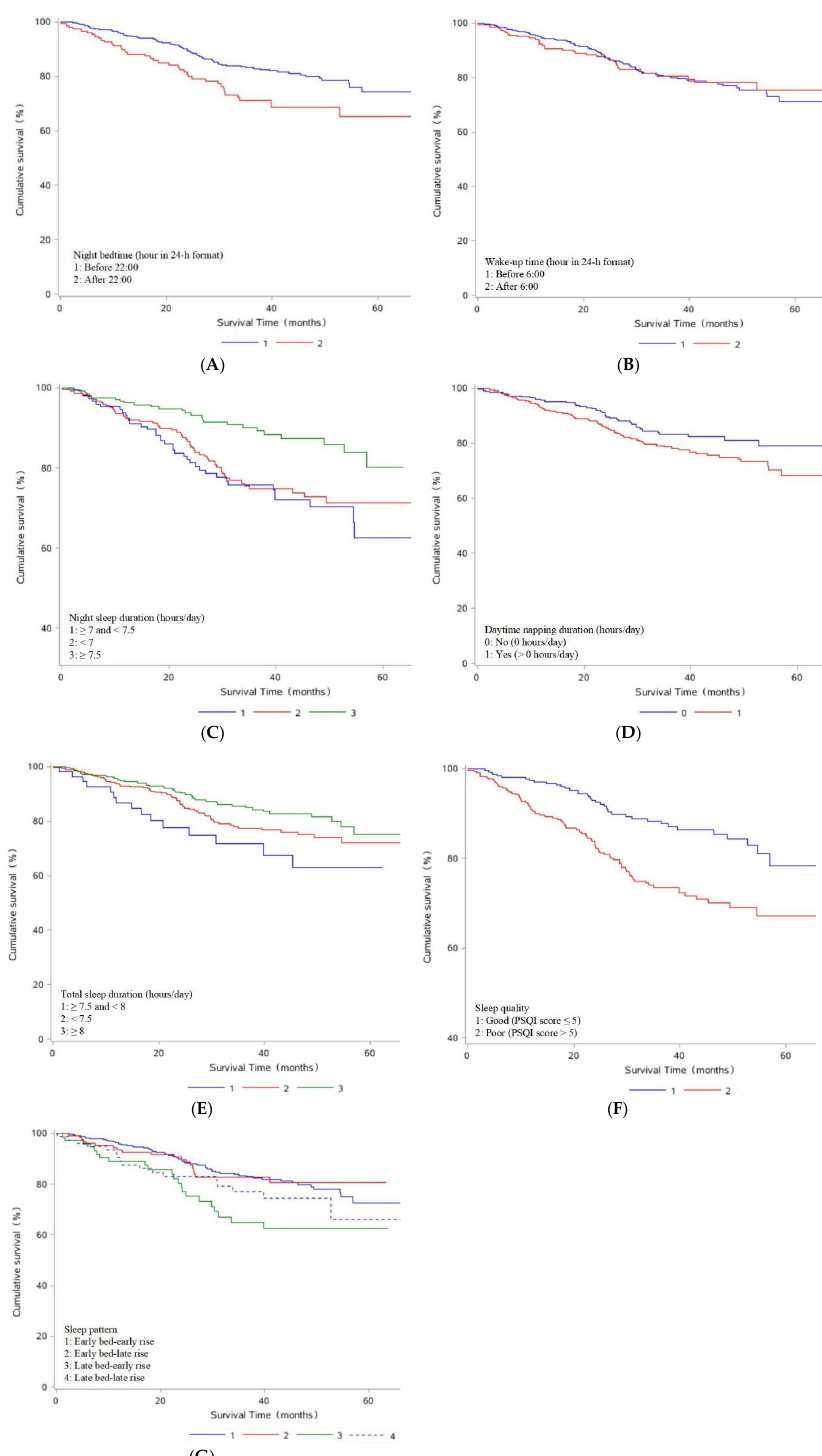
and 95% CI were calculated with the use of the Cox proportional hazards regression model. a Model 1: adjusted for age at diagnosis and body mass index. b Model 2: same as model 1 and further ad- justed for physical activity, electronic product use, smoking, alcohol drinking, tea drinking, educa- tion level, family income per month, menopausal status, parity, histological type, histopathologic grade, FIGO stage, residual lesions, comorbidities, and rotating night shift work.